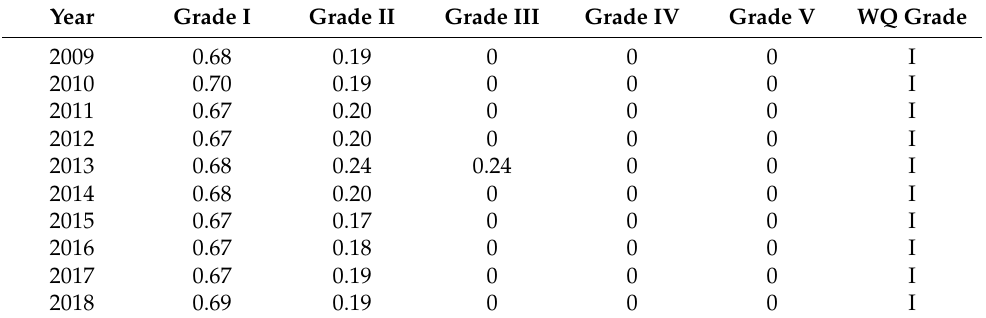
Table A13. Fuzzy integrated evaluation results of Xintanggang Station in Hu-zhou, Zhejiang.